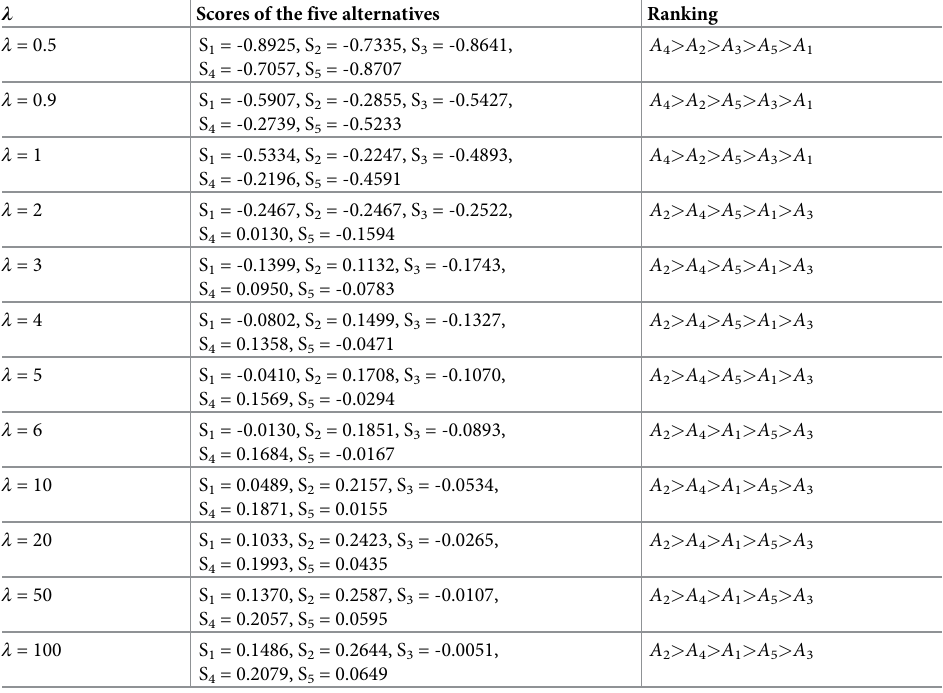
Table 9. The results of experiment